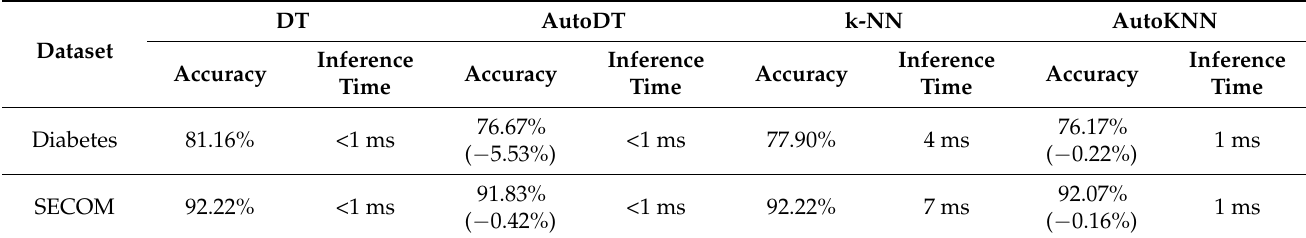
Table 9. Performance evaluation between base models and AEP on the NUCLEO-H743ZI2 board.